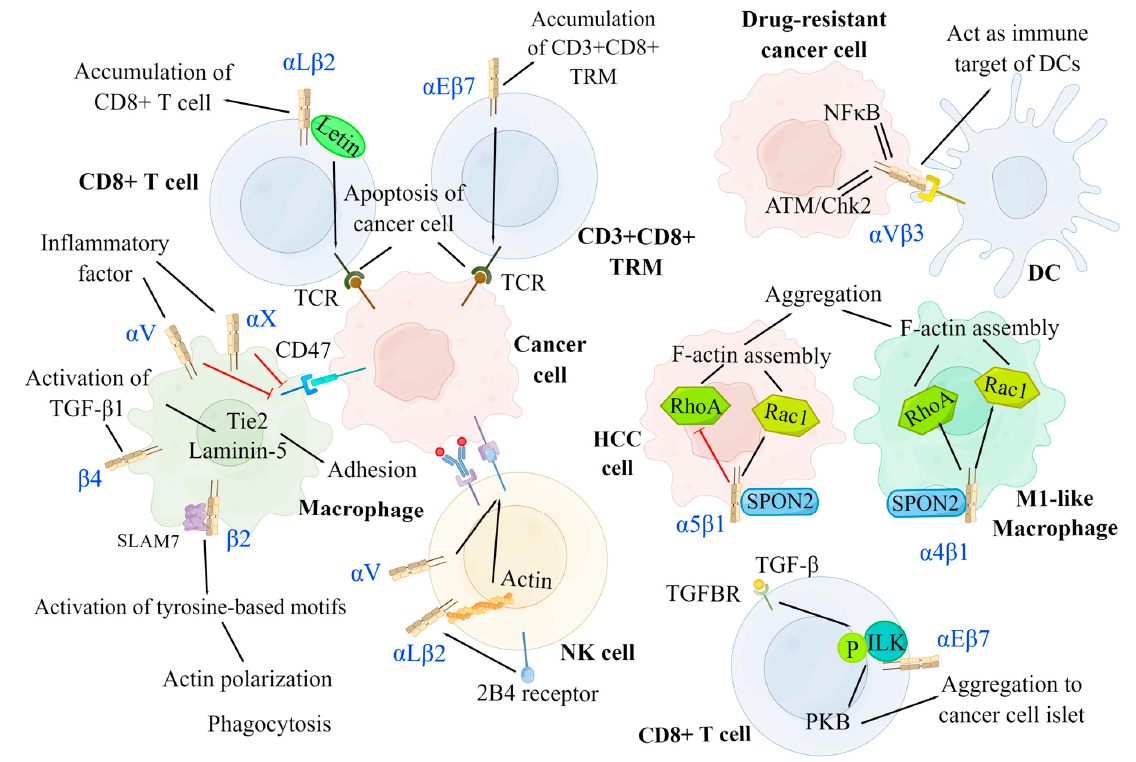
Figure 4. Negative modulation of integrins on cancer development. Integrins can serve as an immune target for DCs to promote antigen presentation. By interacting with several signaling molecules, integrins facilitate the migration, aggregation, and killing of immune cells, including DCs, T cells, NK cells, and macrophages. DCs: α V β 3 integrins on drug-resistant cancer cells have increased expression for ATM/Chk2-and NF- κ B-mediated pathways and act as the immune target of DCs. T cell: α L β 2 integrins on CD8+ T cell and α E β 7 integrins on CD3+CD8+ TRM separately induce the accumulation of CD8+ T cell and CD3+CD8+ TRM at the cancer region and promote the binding between TCR and cancer cell to result in cancer cell apoptosis. α E β 7 integrins on CD8+ T cells are activated by TGF- β via phosphorylated ILK and facilitate the aggregation of CD8+ T cells to cancer islets. NK cell: α L β 2 and α V integrins can enhance the cytotoxicity of NK cells by promoting the adhesion between NK cells and tumor cells and promoting ADCC, respectively. Macrophage: The expression of α L and α X integrins are promoted by in fl ammatory factors, which inhibit the amount of CD47 on cancer cells, thus preventing the function of checkpoint SIRPa-CD47. The signal of SPON2- α 4 β 1 on M1-like macrophage activates both RhoA and Rac1 to facilitate its aggregation. Conversely, the signal of SPON2- α 5 β 1 on HCC cells inhibits the aggregation of HCC cells by suppressing RhoA. CD3+CD8+ TRM: CD3+CD8+ tissue-resident memory T cells, NK cell: Natural killer cell, DC: Dendritic cell, TGFBR: TGF- β receptor, PKB: Protein kinase B, ILK: Integrin-linked kinase, ADCC: Antibody-dependent cell-mediated cytotoxicity, HCC: Hepatoma carcinoma cell.